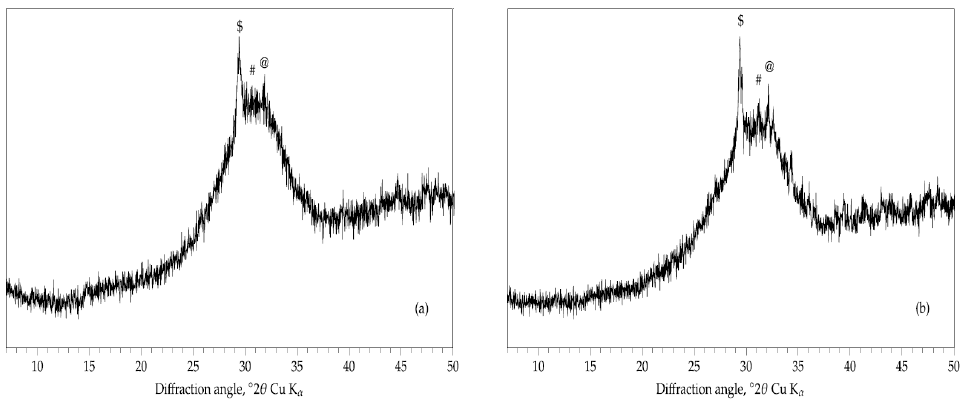
Figure 1. XRD patterns for A ( a ) and B ( b ). Symbols: $ = calcite (CaCO 3 ); # = akermanite (2CaO·MgO·2SiO 2 ); @ = anhydrite (CaSO 4 ).